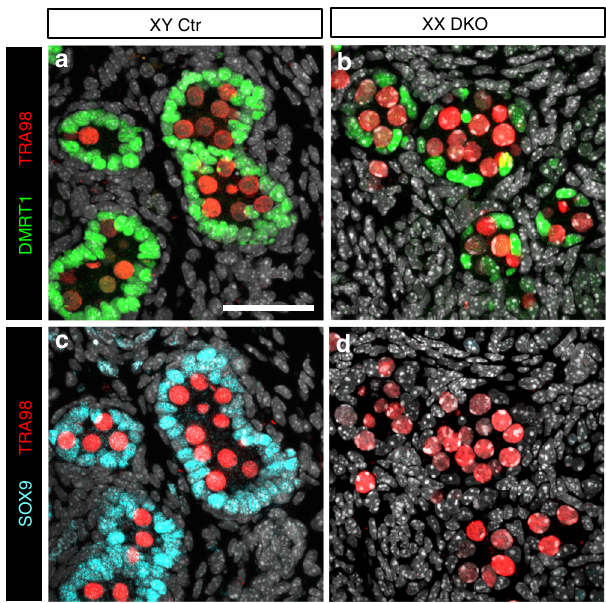
Fig. 6 SOX9 protein is not detected in Runx1 / Foxl2 DKO newborn XX gonads. Immuno fl uorescence for Sertoli cell markers DMRT1 and SOX9 and germ-cell marker TRA98 on consecutive sections in XY control ( a , c ) and XX Runx1/Foxl2 DKO gonads ( b , d ) at birth. Scale bar: 50 µ m. At least three independent biological replicates were analyzed and the images presented are representative of all